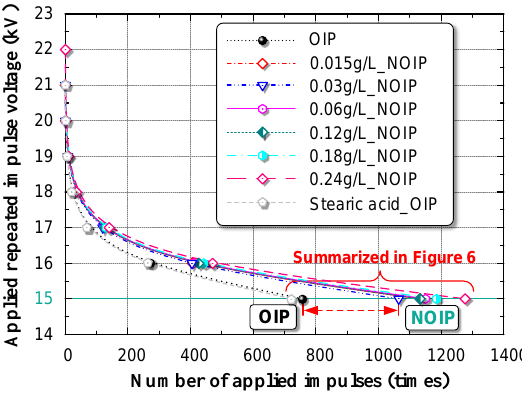
Figure 8. Number of applied impulses before breakdown occur for OIP and NOIP.